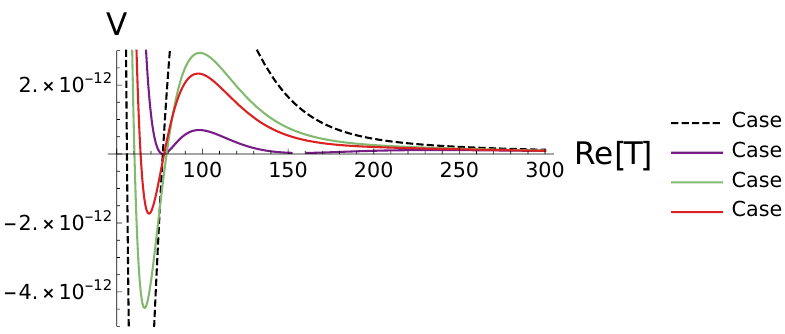
Figure 2 . A plot of the potentials of Cases 0{3 with T R varying and all other (cid:12)elds (cid:12)xed at their (cid:12)rst critical point values (vid. appendix B). All of the minima in this potential are anti-de Sitter, with the exception of Case 1, which is a Minkowski minimum. Cases 0, 2, and 3 are true minima.